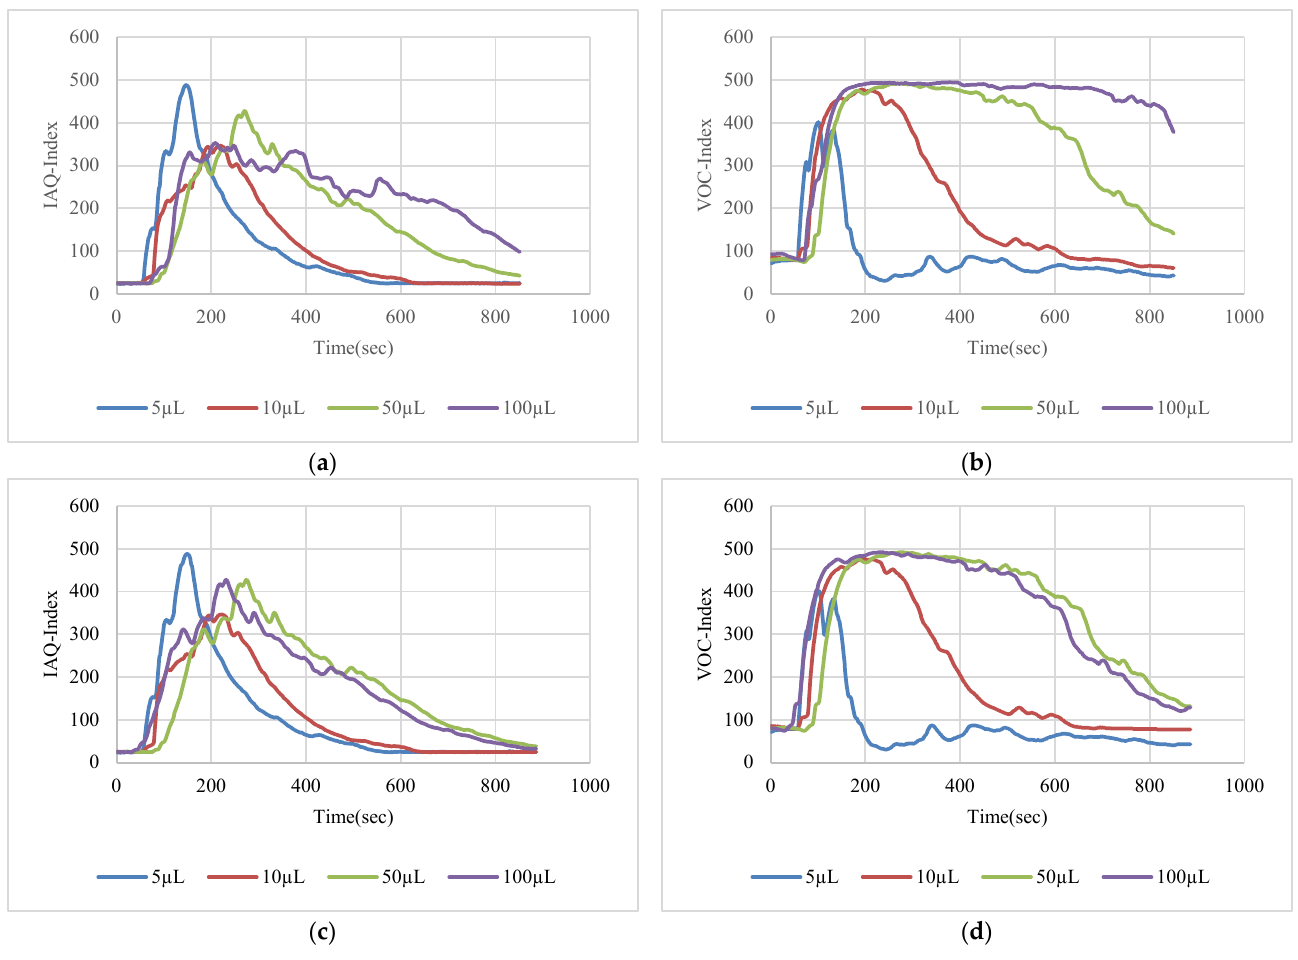
Figure 15. Test results for ethanol: ( a ) BME688 40 cm, ( b ) SGP41 40 cm, ( c ) BME688 100 cm, ( d ) SGP41 100 cm.